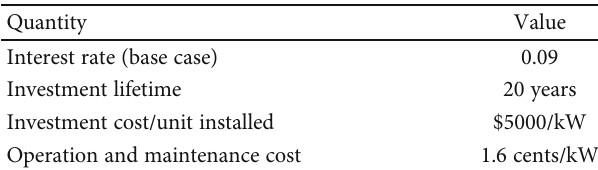
Table 3: Solar power cost data